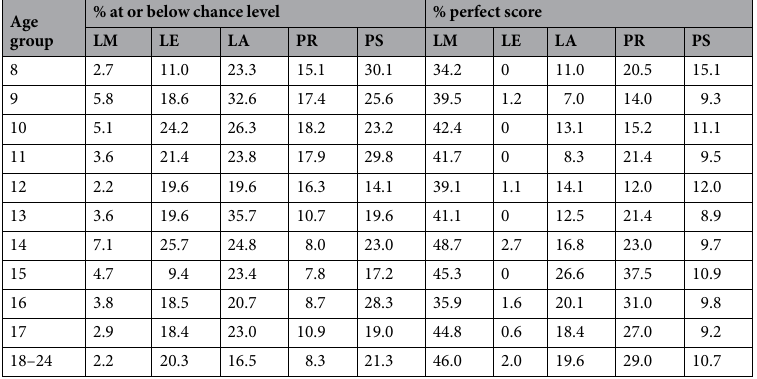
LA = location allocentric, PR = path route, PS = path